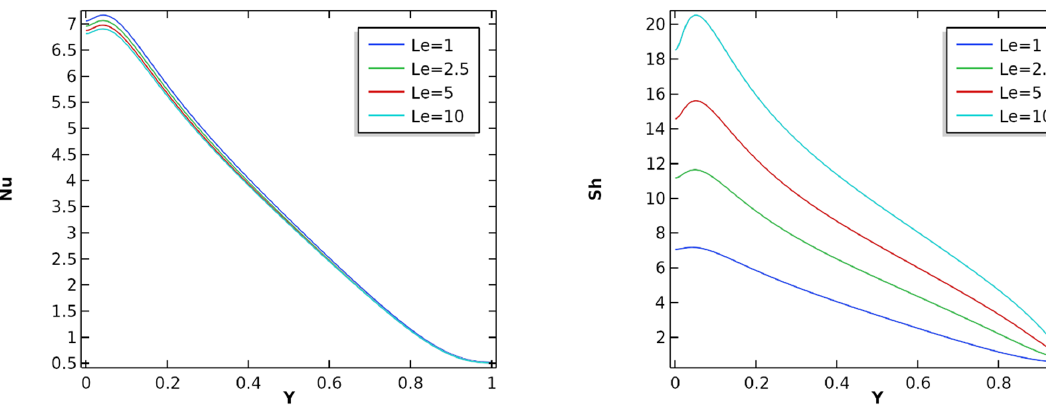
Figure 13. Streamlines (column 1), isotherms (column 2), and isoconcentration (column 3).